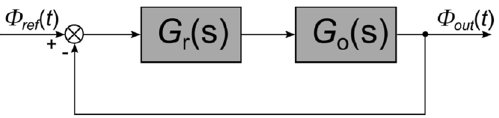
Figure 5. Example schematic of the control system Φ ref reference luminous flux, Φ out output luminous flux.